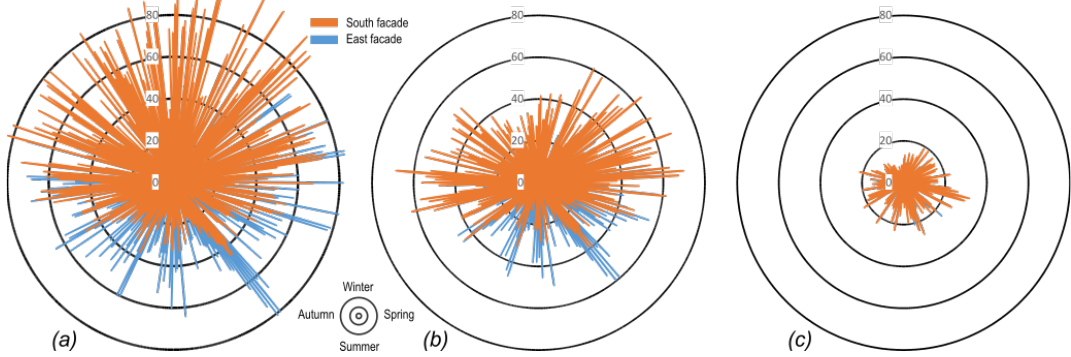
Figure 7. Yearly variation of the thermally induced temperature gradients (K) in New York for values of view angles of 0° ( a ), 30° ( b ) and 60° ( c ) for the worst combination of glass type/insulation type in Tables 5 and 6.